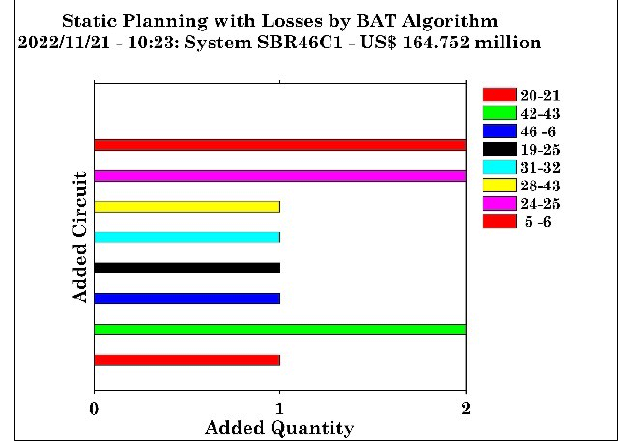
Figure 19: Case WOR - SB-46/79 t est system. Planned circuits. Source: BATp optimizer, (2022).